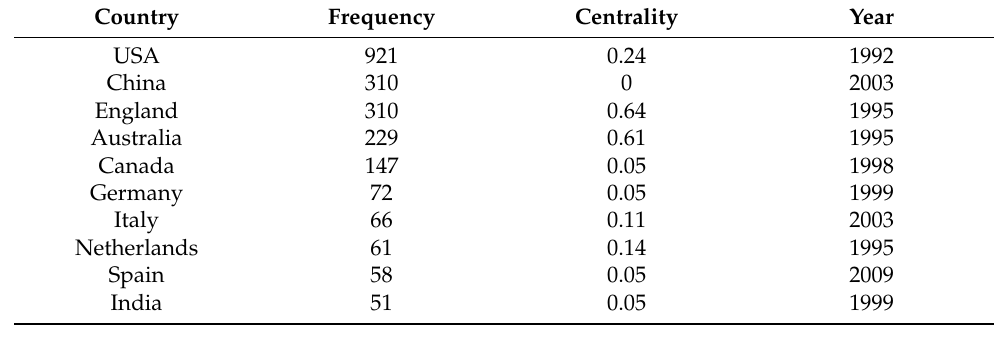
Table 3. Top 10 countries based on frequency.